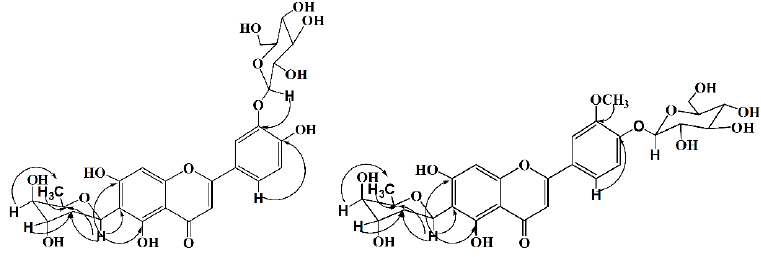
Figure 2. Key HMBC correlations of compounds 1 and 2 .